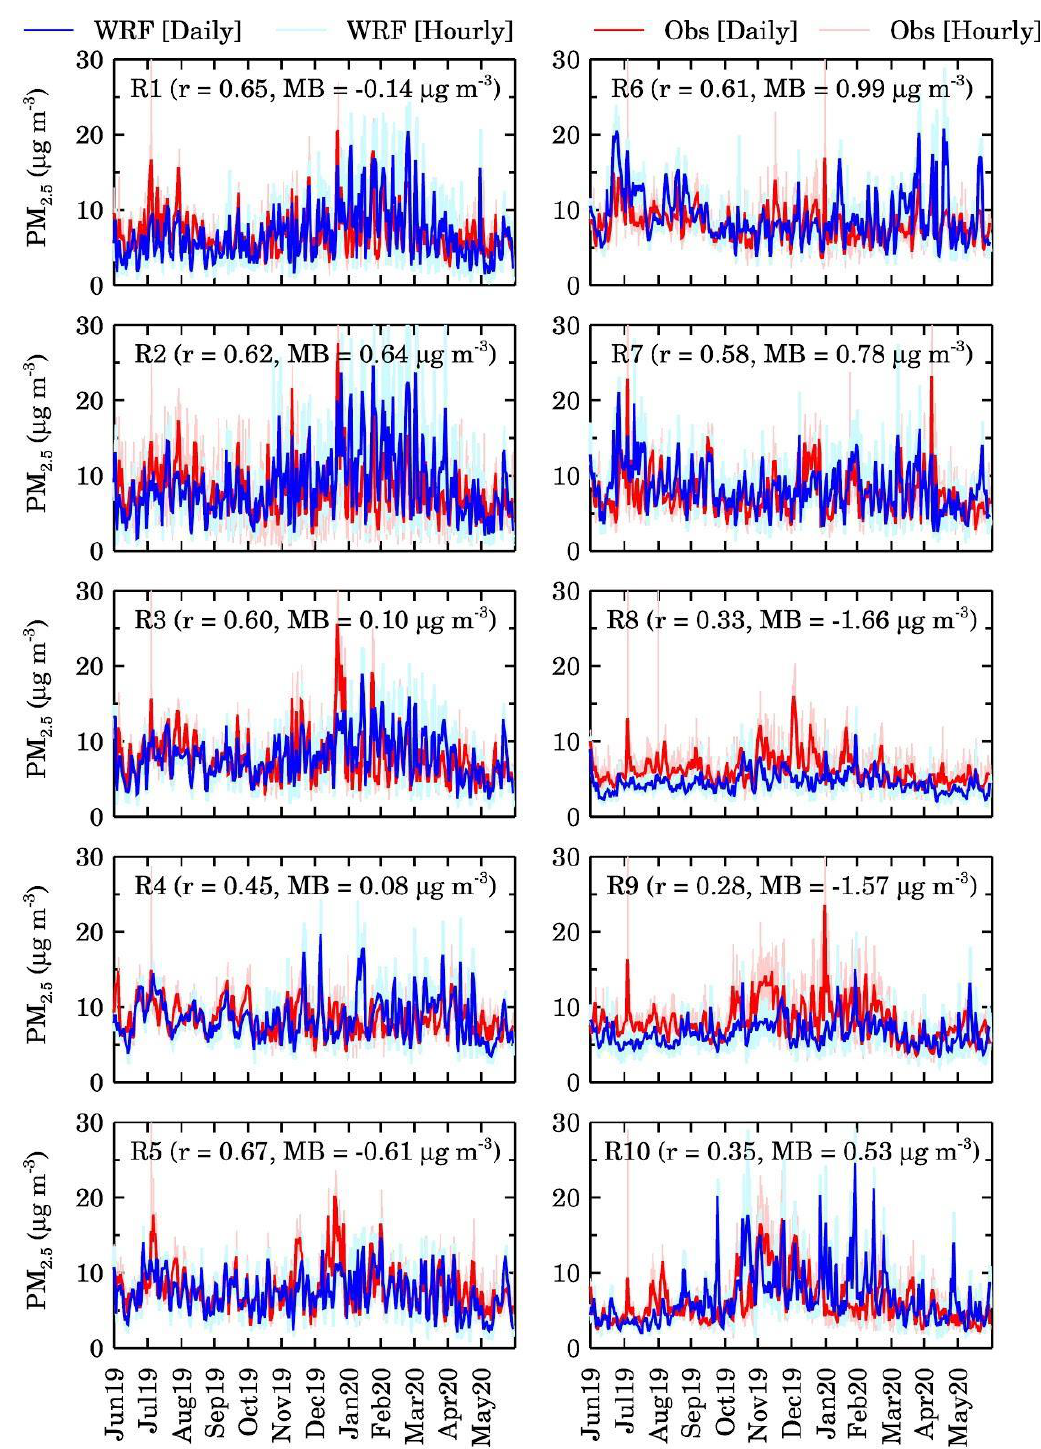
Figure 10. Variations in hourly and daily averaged WRF-Chem forecasted surface PM 2.5 mass concentrations against the EPA AirNOW observations in 10 EPA regions from 1 June 2019 to 31 May 2020. r and MB for each region estimated using paired data for the full year are also shown.